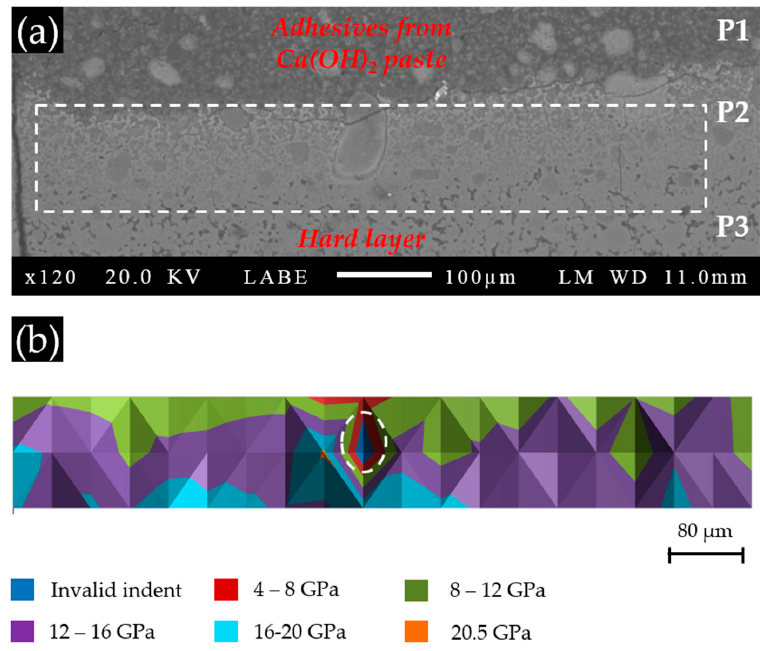
Figure 9. ( a ) The BSE image of S2 with a Ca(OH) 2 paste addition of 5 g; ( b ) the corresponding elastic modulus. elastic